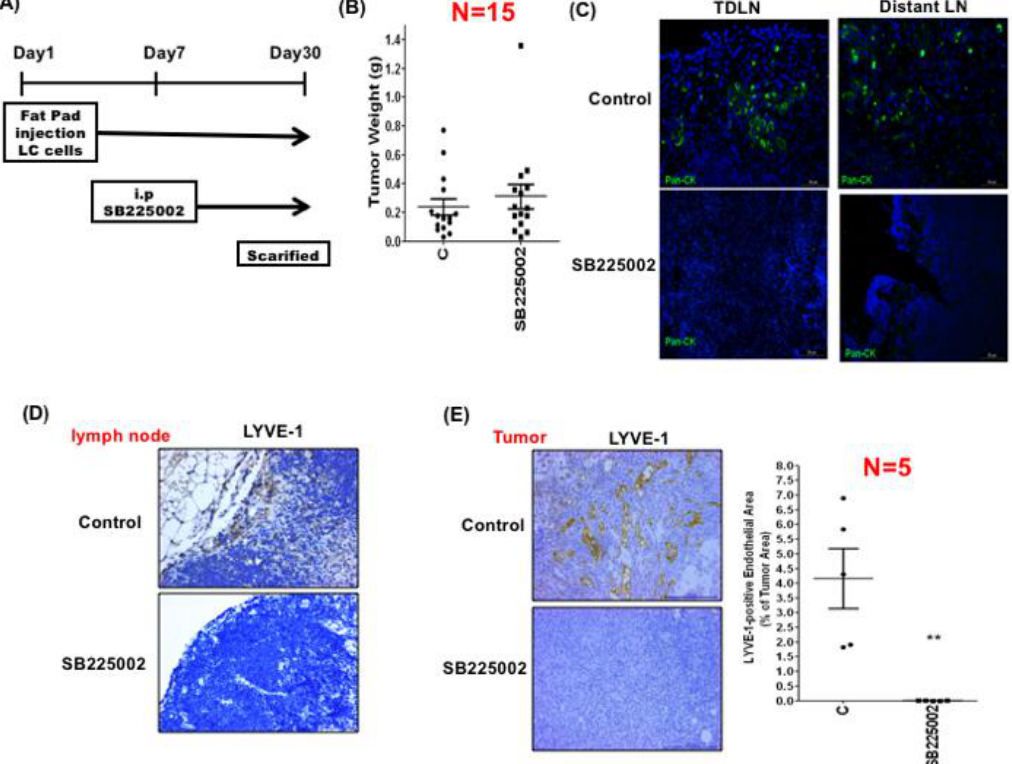
Figure 3. LEC-released chemokines promote cancer cell invasion and lymphangiogenesis in the lymph nodes via CXCR2. ( A ) LC cells were injected into the mammary fat pads of nude mice. After one week, mice were treated with vehicle (control) or CXCR2 inhibitor SB225002 for another three weeks. The tumors and lymph nodes were harvested for analysis. ( B ) The tumor weights of the control and SB225002-treated mice were not significantly di ff erent. ( C ) Immunofluorescent staining demonstrated that the number of pan-cytokeratin-positive cancer cells was significantly decreased in the SB225002-treated mice, suggesting that inhibition of CXCR2 reduced the invasion of cancer cells to lymph nodes. ( D ) Lymphangiogenesis in the tumor-draining lymph nodes was suppressed by SB225002. Scale bar: 50 µ m. ( E ) Lymphangiogenesis in the tumors was also inhibited by SB225002. Scale bar: 50 µ m. ** p < 0.01.